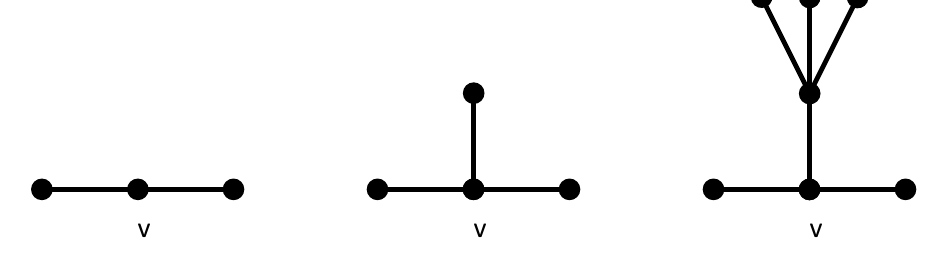
Figure 18: The types of configuration at 𝑣